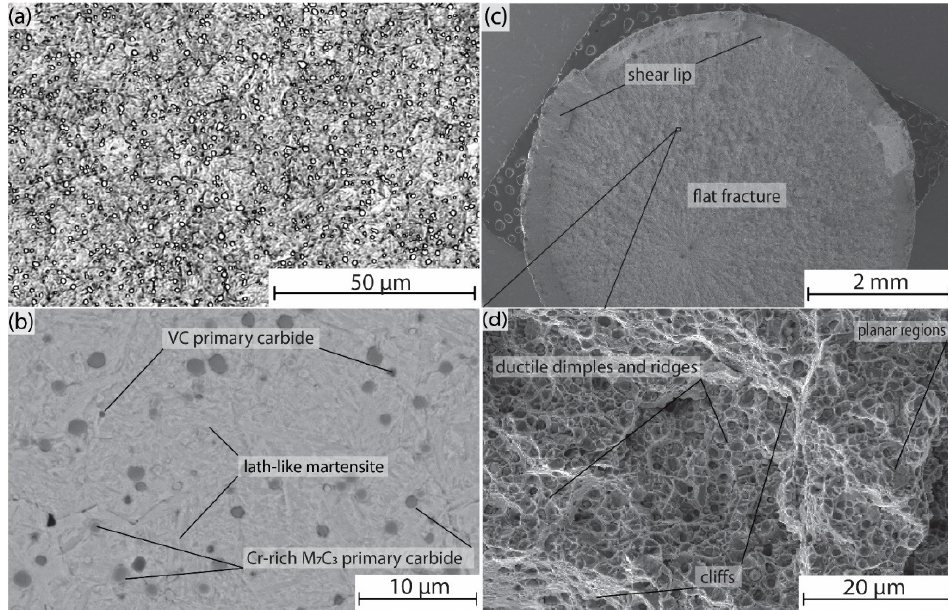
Figure 5. ( a ) Reflected light image of 550 °C sample. Bright spots, interpreted as retained austenite, are fewer than those seen in the As ‐ Hardened sample. ( b ) Backscatter electron image highlighting the lath ‐ like as ‐ quenched martensite and mixed primary carbides. ( c ) Wide ‐ field secondary SEM image of fracture surface highlighting a shear lip with flat fracture in central region. ( d ) Small ‐ scale secondary electron image highlighting brittle cliffs and planar regions with ductile dimples and ridges.